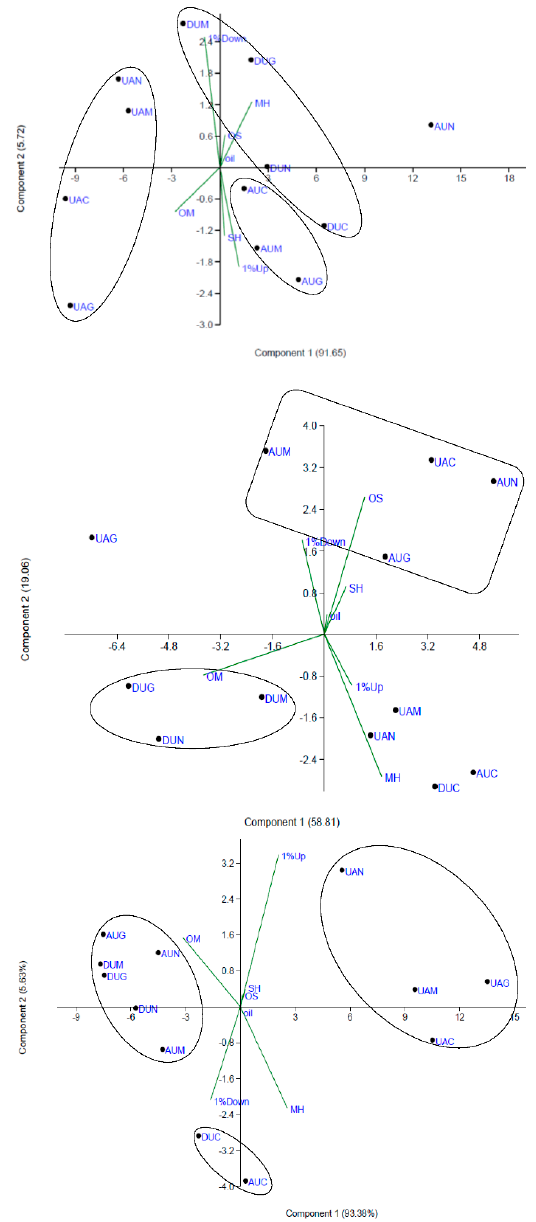
Figure 6. Scatter plot based on the first two principal components of chemical profile data, demonstrating the relationships among some important characteristics in the essential oil of Thymus daenensis ( top panel ), T. fedtschenkoi ( middle panel ) and T. vulgaris ( bottom panel ) and employed treatments. During growth, three UVA levels (ambient, enriched, excluded) were realized in combination with spraying protectants [water (control), melatonin, glutathione, iron − zinc nanofertilizer]. AUM, melatonin under ambient UVA; AUG, glutathione under ambient UVA; AUN, iron − zinc nanofertilizer under ambient UVA; AUC, control under ambient UVA; UAM, melatonin under enriched UVA; UAG, glutathione under enriched UVA; UAN, iron − zinc nanofertilizer under enriched UVA; UAC: control under enriched UVA; DUM, melatonin under excluded UVA; DUG, glutathione under excluded UVA; DUN, iron − zinc nanofertilizer under excluded UVA; DUC, control under excluded UVA.